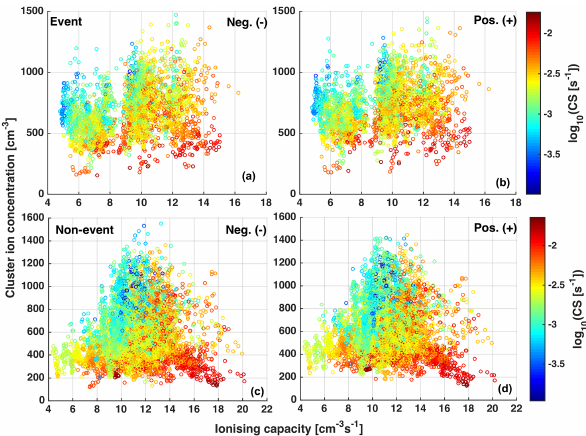
Figure 12. The 1h cluster (0.8–1.7nm) ion concentration as a func- tion of the total ionising capacity on new particle formation event days (upper panel) and non-event days (lower panel), with the con- densation sink (CS) indicated on the colour scale. Figure 13. The cluster (0.8–1.7nm) ion concentration as a function